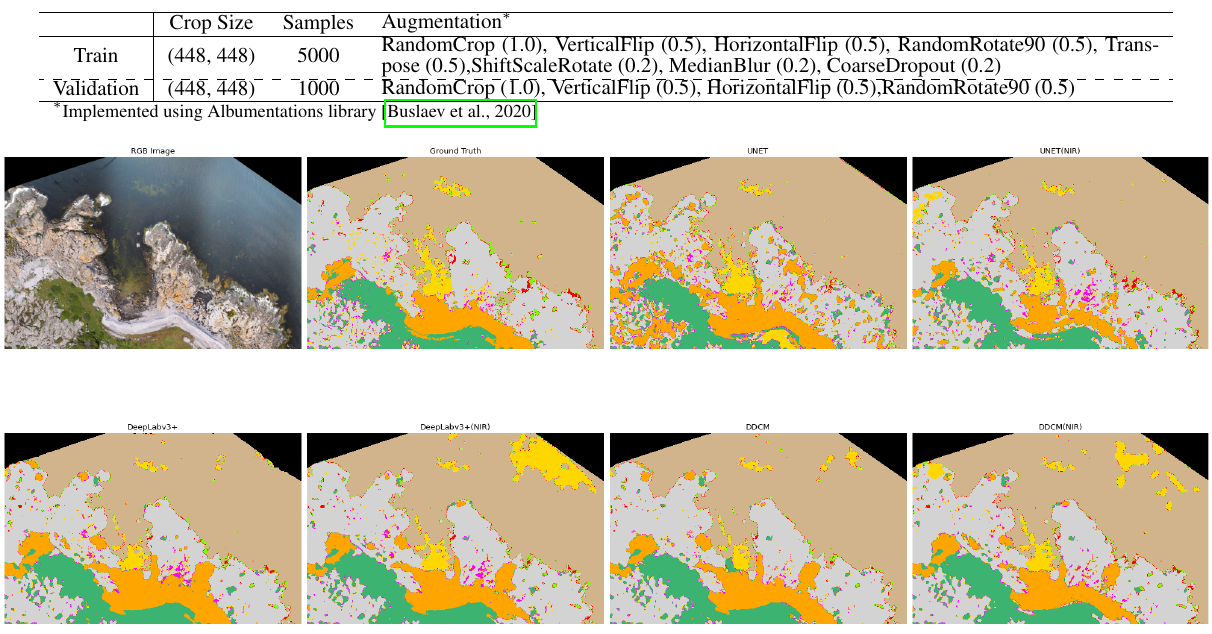
Table 2. Data Set parameters